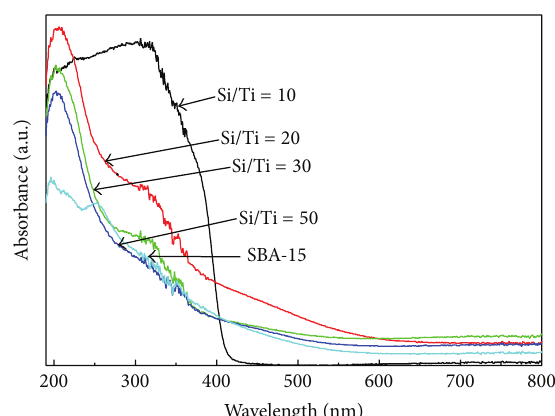
Figure 2: DRS UV-Vis spectra of different Ti-containing samples.